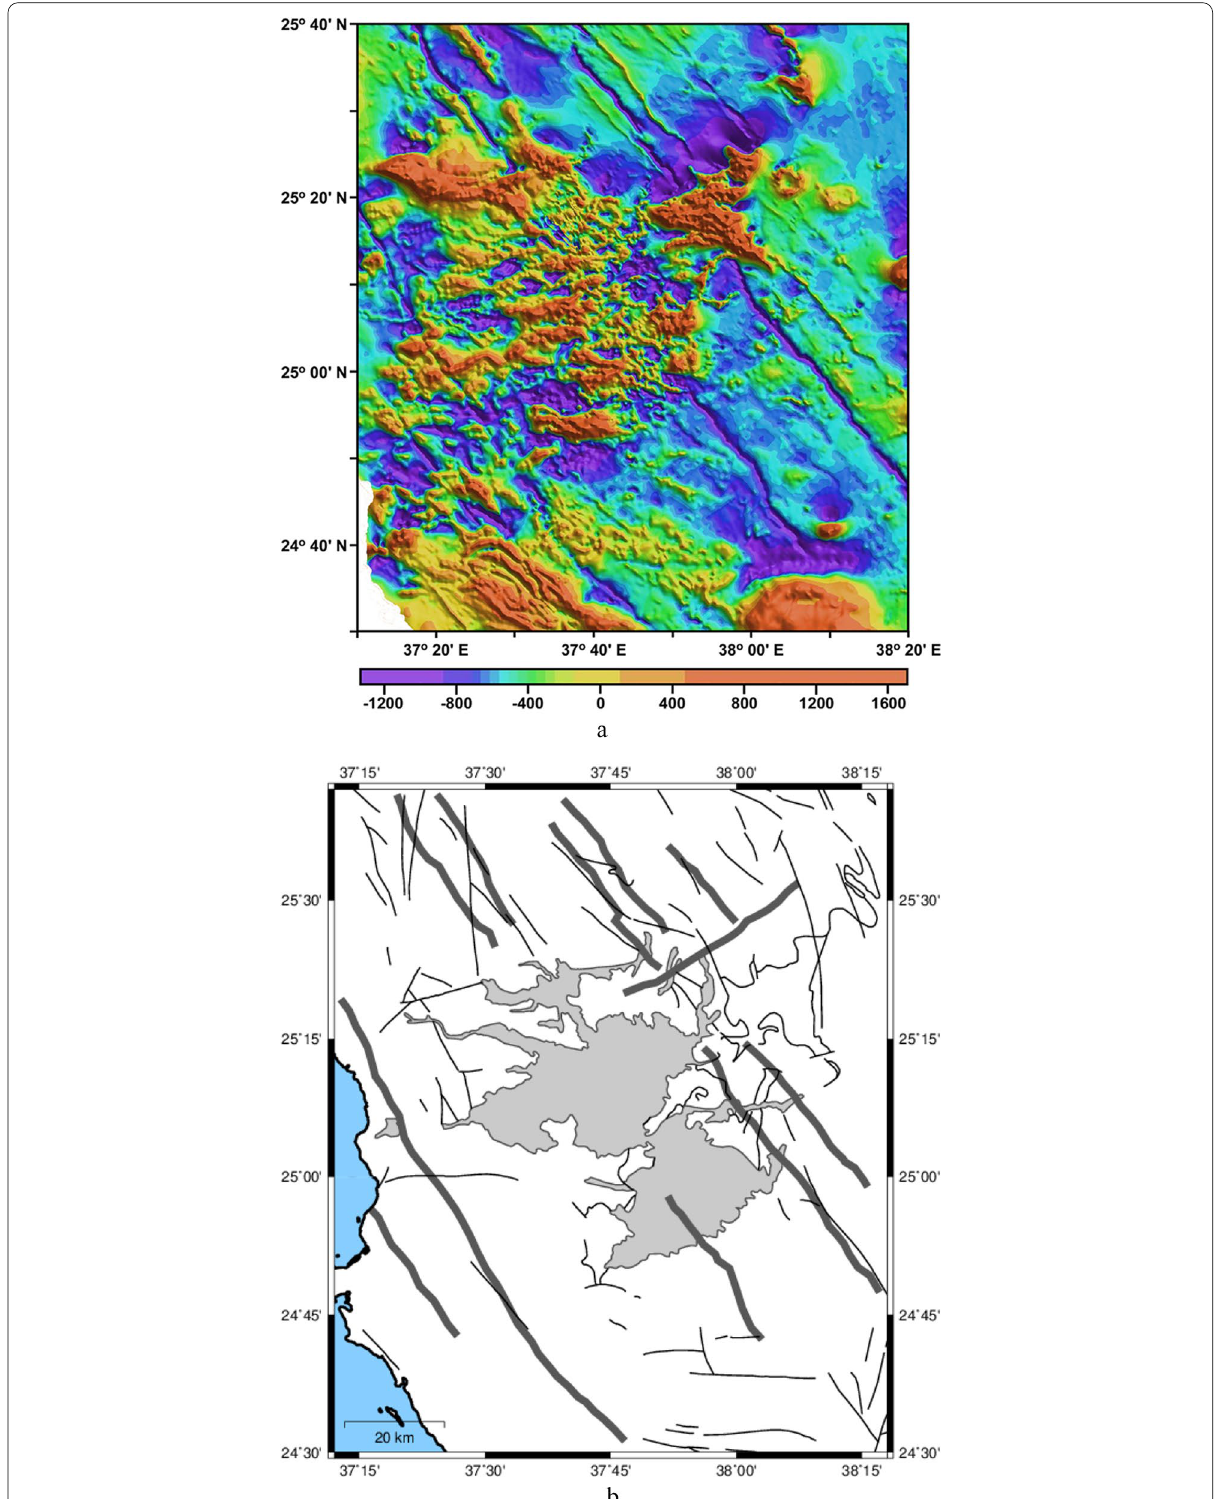
Fig. 7 a Reduced to the pole of aeromagnetic anomalies map of Harrat Lunayyir and surrounding area. (After Rashed et al., 2020). b Map showing the aeromagnetic trends mirrored from the aeromagnetic map shown in a (thick lines) and observed surface faults (thin